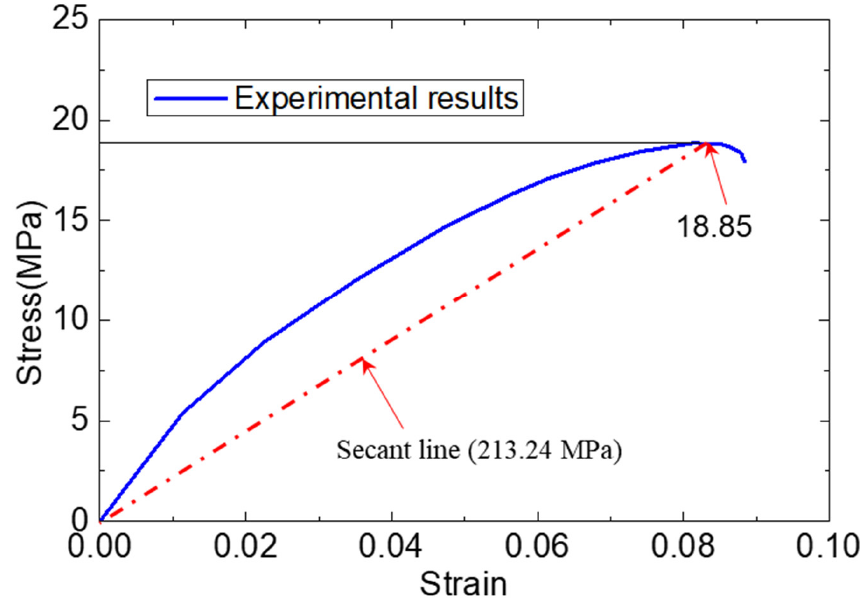
Figure 1. Mechanical behavior of adhesive in tensile experiment and finite element model.